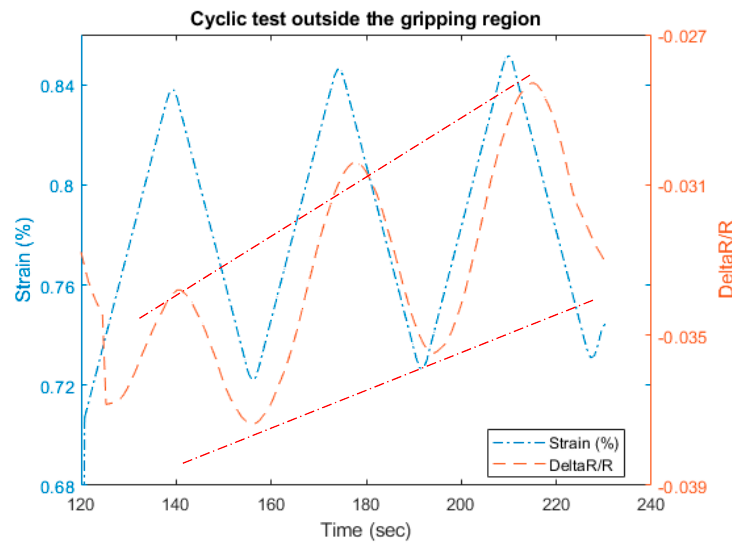
Figure 15. Resistance measurements for the cyclic test outside the gripping region.